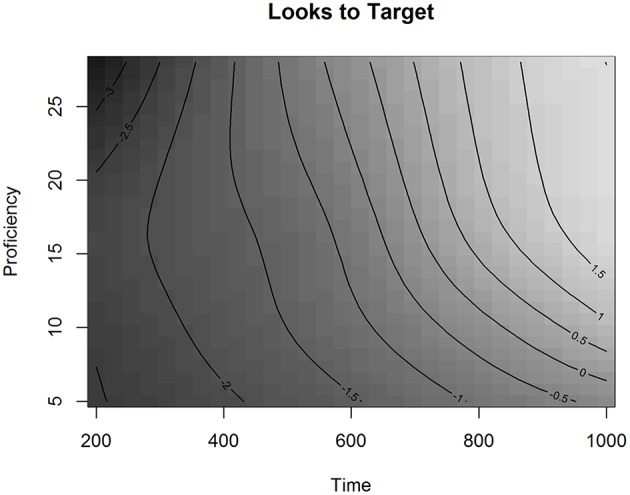
The effect of Proficiency over Time in Experiment 2 in the L2 group, fitted values.